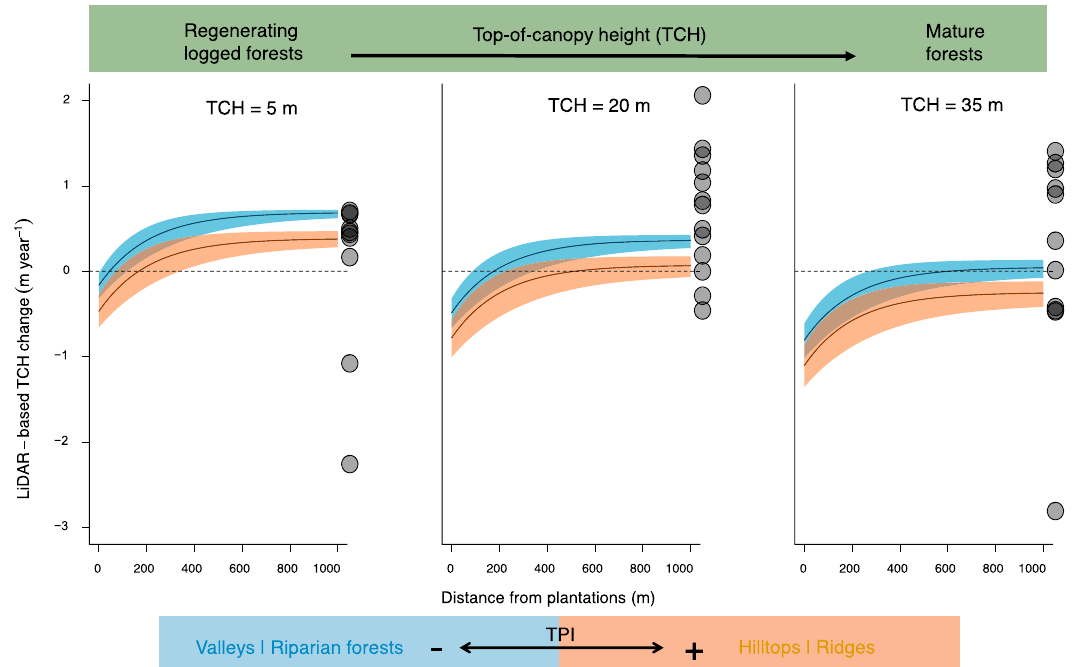
Fig. 5 Fragmentation and topographic effects on canopy height change during the 2015 – 2016 ENSO event. Predicted effects of distance from oil palm plantations and topographic position (TPI) on canopy height growth, obtained by fi tting nonlinear models with a spatial autocorrelation structure. The solid black curves are predictions based on median parameter values obtained by fi tting models to 24 subsets of the dataset, each composed of 5000 measurements; 95% con fi dence intervals are based on uncertainty in those parameter estimates (see Supplementary Methods 7 and 12 for details). Predictions are shown for short, medium and tall canopies, with initial heights of 5, 20, and 35